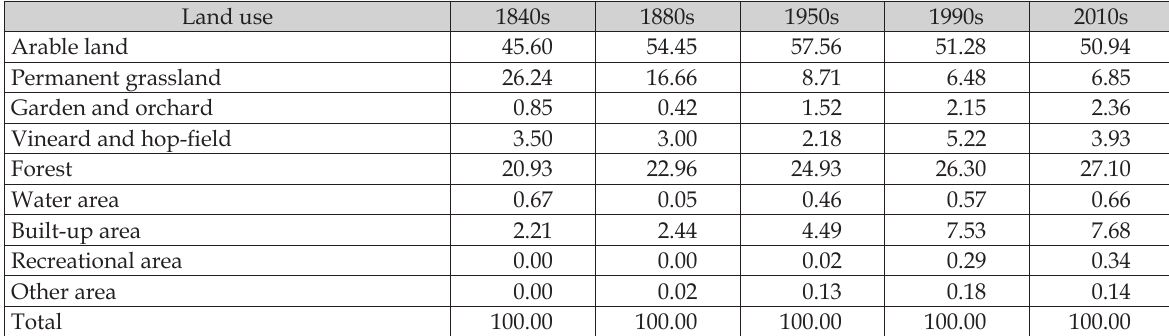
Table 3. land use in the Hodonín region (proportion in%) in the 1840s, 1880s, 1950s, 1990s, 2010s. Land use